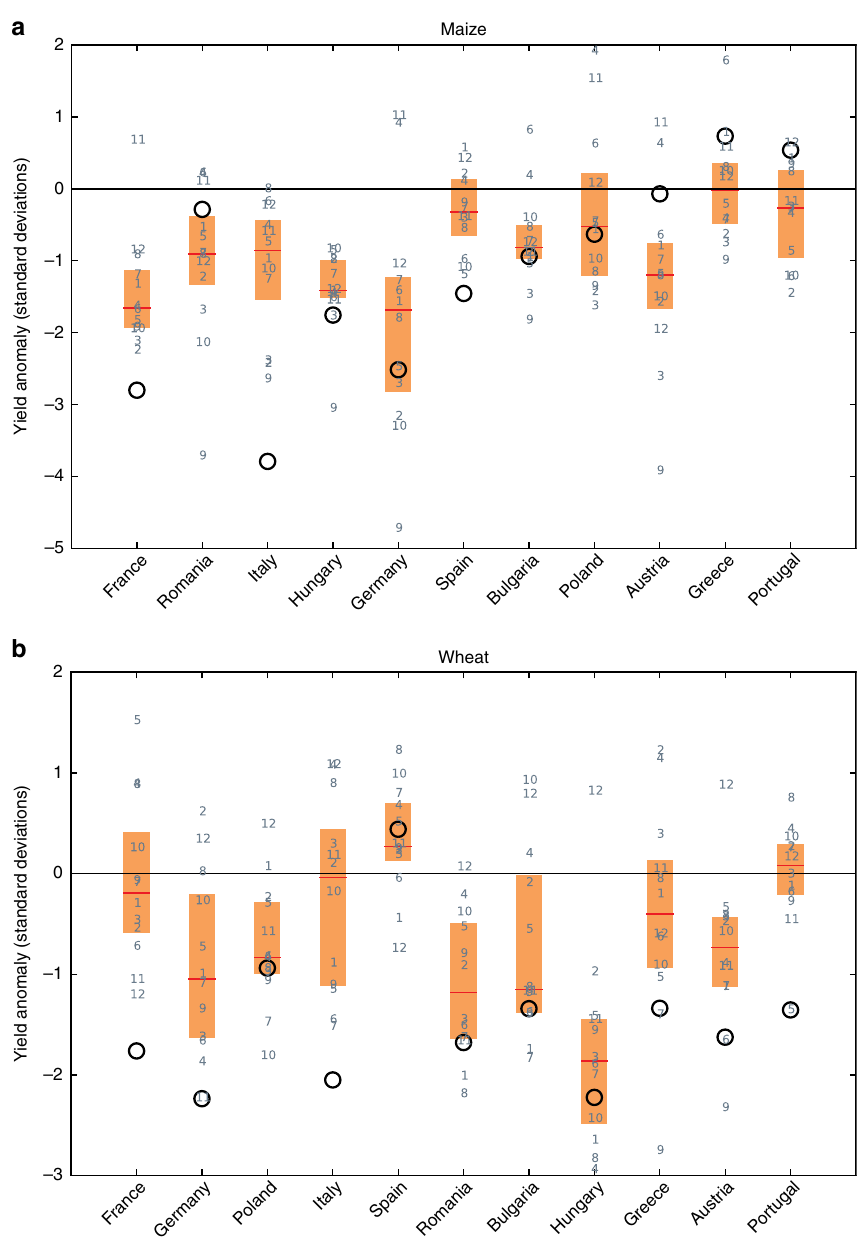
Fig. 3 Crop yield anomalies in 2003. a Maize, b wheat. Black circles are observed data from FAOSTAT. Grey numbers are the 12 global gridded crop models; red lines indicate the median, and orange boxes the interquartile range, of the model ensemble. Countries are ordered by their total